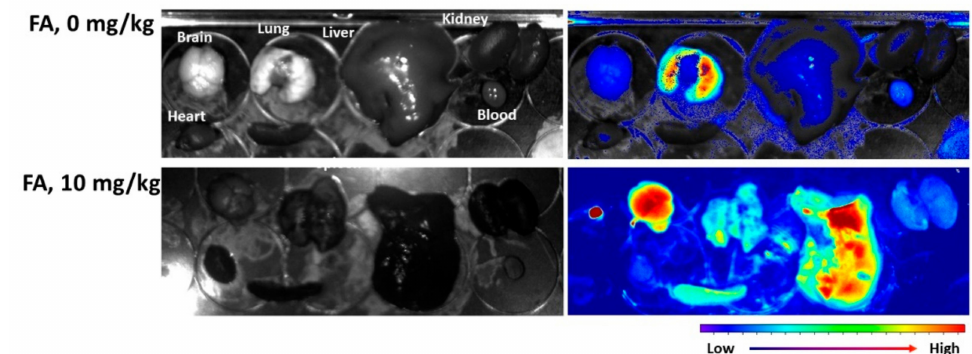
Figure 10. Pulmonary metastasis model of Y79 cells for evaluation of targetability of FAPEGtaCe6 nanophotosensitizers. For pulmonary metastasis of Y79 cells, 5 × 10 5 cells/0.1 mL PBS were intra- venously (i.v.) administered via the tail veins of nude BALb/C mice. Three weeks later, nanophoto- sensitizers (10 mg/kg) were administered via the tail veins of nude BALb/C mice. For blocking of the folate receptors of Y79 cells in the mouse lungs, FA (10 mg/kg, in 0.1 mL PBS) was i.v. injected 30 min before injection of nanophotosensitizers. One day later, the mice were sacrificed and dissected to observe the organs and the biodistribution of nanophotosensitizers with a Maestro TM 2 small animal imaging